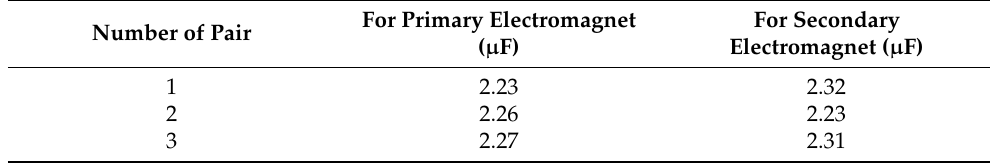
Table 1. Measured capacitances.